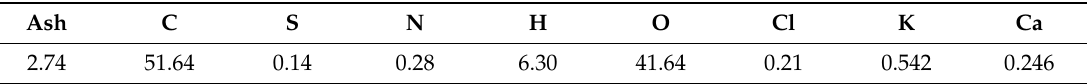
Table 2. Selected characteristics of the biomass pellets (content of dry mass in